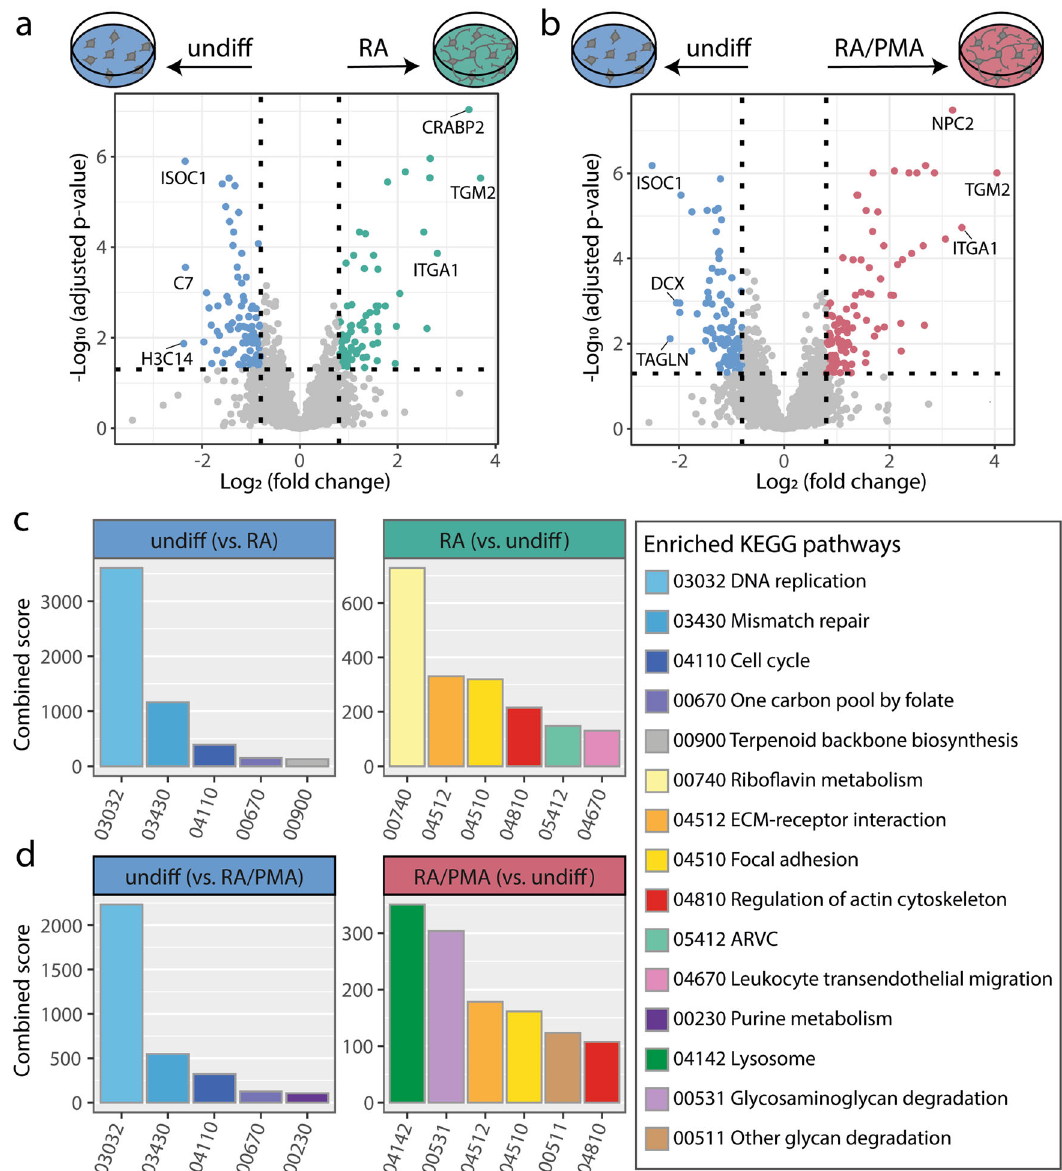
Fig. 3 Relative quanti fi cation and enriched KEGG pathway analysis of undifferentiated versus RA- and RA/PMA-differentiated SH-SY5Y cells. For relative global protein abundance quanti fi cation of the different cell culture conditions, a two-tailed t -test was performed and adjusted p-values were calculated according to Benjamini and Hochberg. The log2(fold-change) was plotted against the − log10(adjusted p -value) in volcano plots. Quanti fi ed proteins with a log2(fold-change) < − 0.8 or >0.8 and an adjusted p -value < 0.05 were considered signi fi cantly up- or down-regulated, respectively. The gene names of the three top protein hits up- or downregulated in undifferentiated or differentiated cells are labelled in the volcano plots. Signi fi cantly up- or downregulated proteins were used for KEGG pathway enrichment analysis. a Volcano plot of RA-differentiated cells (RA, green) versus undifferentiated cells (undiff, blue). b Volcano plot of RA/PMA differentiated cells (RA/PMA, red) versus undifferentiated cells (undiff, blue). c Enriched KEGG pathways with high combined scores in RA-differentiated cells vs. undifferentiated cells (see legend for enriched pathways). d Enriched KEGG pathways with high combined score in RA/PMA differentiated vs. undifferentiated cells (see legend for enriched pathways). ISOC1 isochorismatase domain containing 1, C7 complement C7, H3C14 H3 clustered histone 14, ITGA1 integrin subunit alpha 1, CRABP2 cellular retinoic acid-binding protein 2, TGM2 transglutaminase 2, DCX doublecortin, TAGLN transgelin, NPC2 NPC intracellular cholesterol transporter 2, ECM extra cellular matrix, ARVC arrhythmogenic right ventricular cardiomyopathy. Figure generated using Supplementary Data